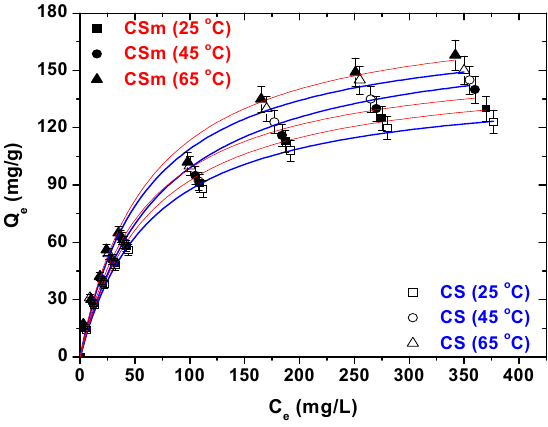
Figure 10. Isotherms for the adsorption of Hg(II) onto CS and CSm at 25, 45 and 65 °C (fitting to Langmuir and Freundlich equations).